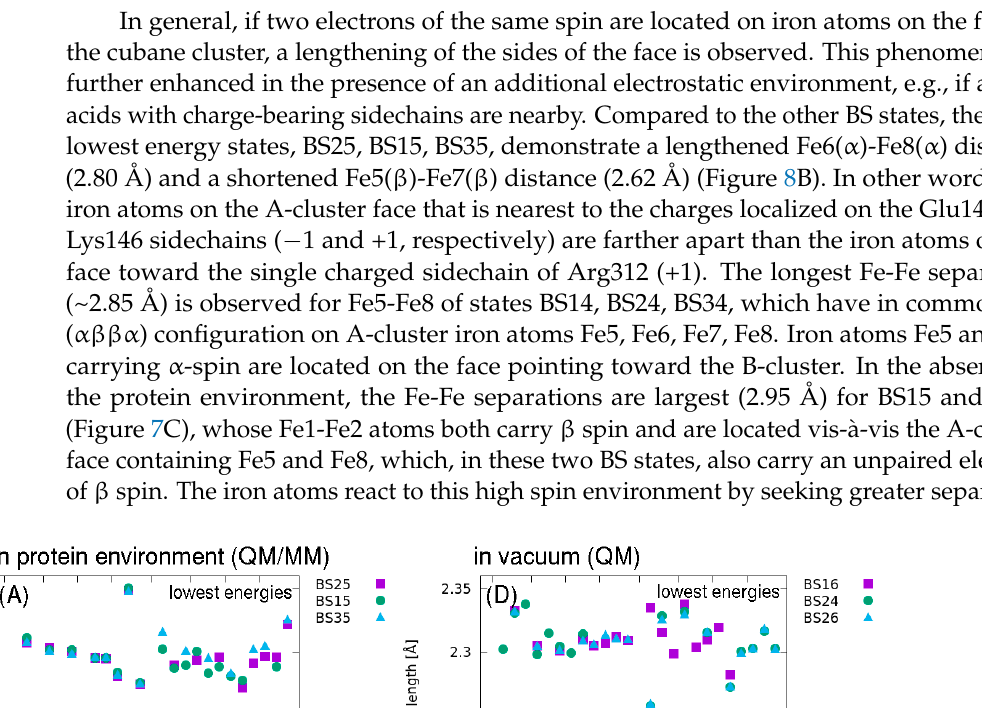
Figure 8: Fe-S bond lengths (Å) of low, medium, and highest energy BS states are compared for the DCC within (A) protein environment and (B) vacuum. The bonds types are classified according to position within each cubane, “top” face, “bottom” face, “sides”. In general, the electrostatic protein environment induces more systematic Fe-S bonding patterns, such as for the BS24, BS25, BS26 states (circled) in the B-cluster. Figure drawn using gnuplot and TGIF.